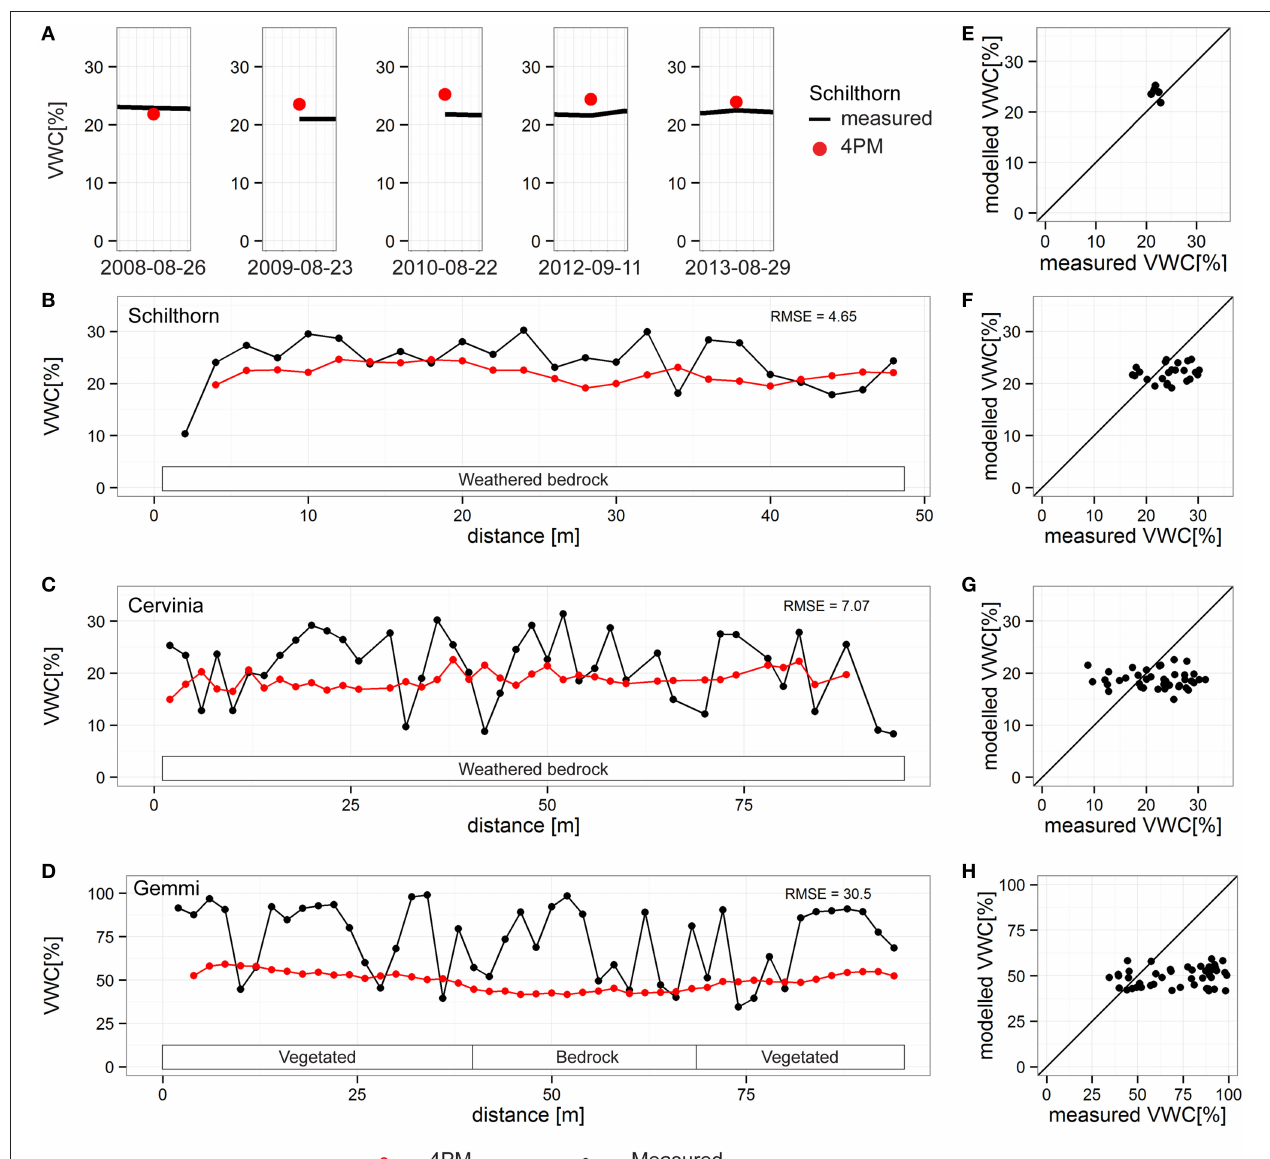
FIGURE 8 | Comparison of the modeled VWC (4PM) to the measured VWC (FDR) at Schilthorn (A,B), Cervinia (C), and Gemmi (D). The values of the uppermost model grid cells are compared to the spatial FDR measurements (B–D) and to the FDR monitoring sensors at different dates (A) . The overall fit for each validation method is given in the right column (E–H)